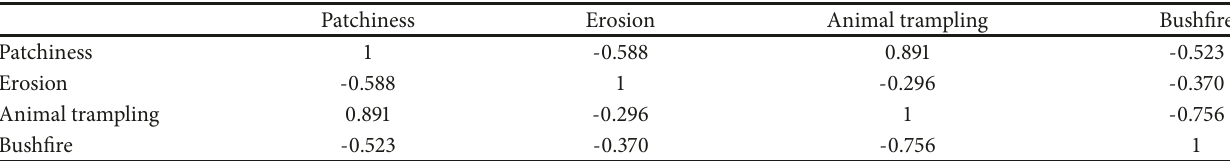
Table 4: Intercorrelations (Pearson) between the environmental variables (soil erosion, animal trampling, tree felling, bushfire, and patchiness) in bird dataset, during the dry season. A correlation above/below ± 0.61 is significant at p = 0.0013 ∗∗∗ ; ± 0.45 at p = 0.01 ∗∗ and ± 0.33 at p = 0.05 ∗ .